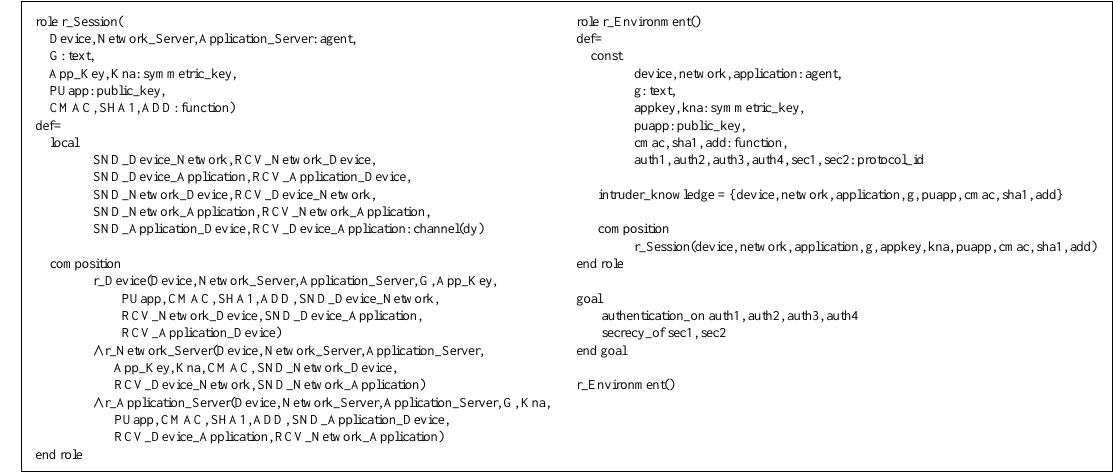
Figure 10. r_Session role and r_Environment role.